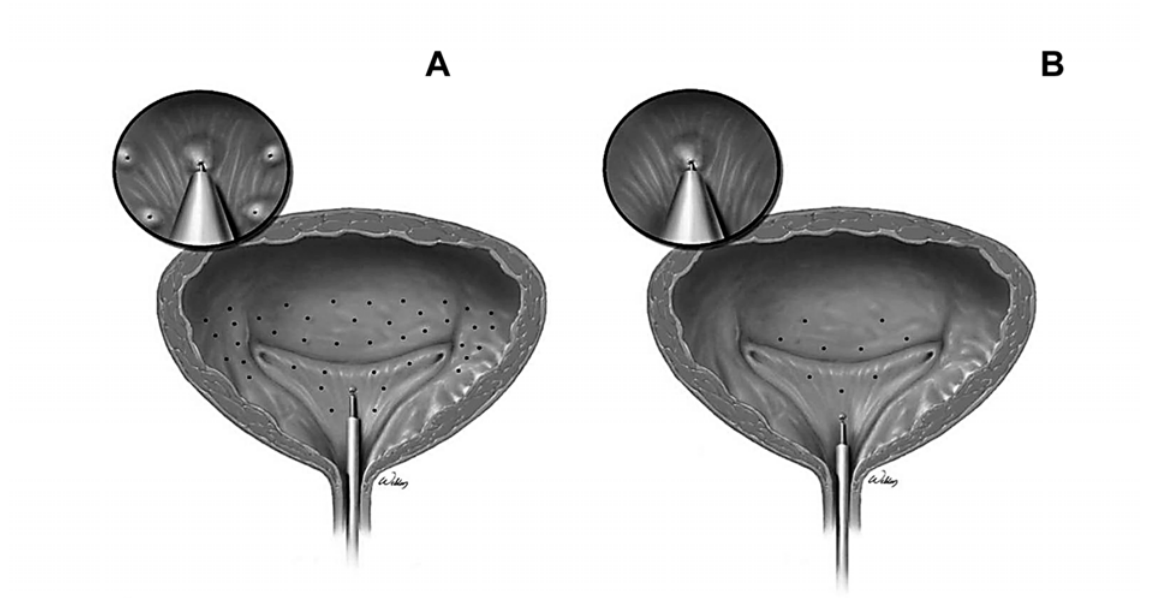
Figure 1 – Smith et al., botulinum toxin injection protocol. A) Neurogenic detrusor overactivity protocol. B) Non-neurogenic detrusor overactivity (Reprinted with permission from Elsevier Inc, Urology, Smith CP et al., ref.